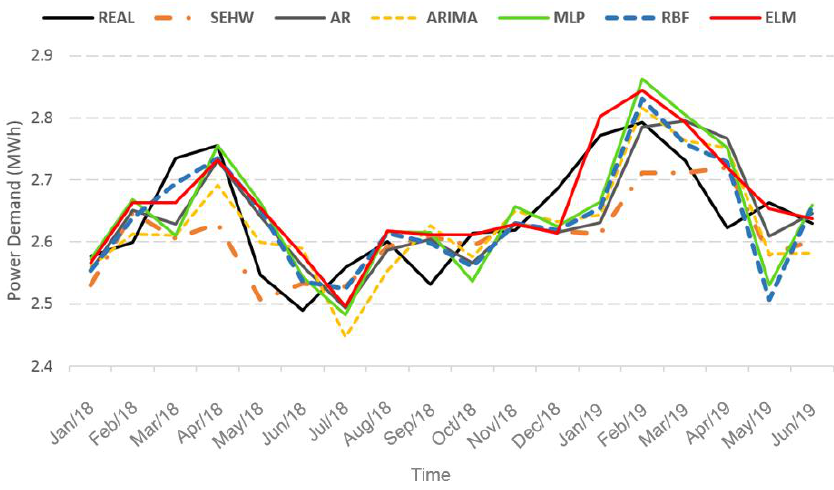
Figure 4. Graph comparing actual data with data predicted for 1 step ahead, using HW, AR, ARIMA, MLP, RBF, and ELM models. Table 6. Forecast results for three steps ahead, compared by the error measures MSE, MAE, MAPE, and their respective performance rankings. Three steps ahead